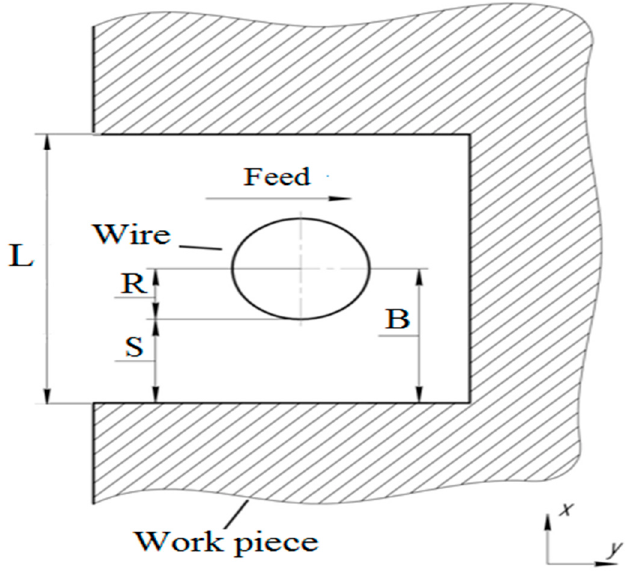
Figure 4. WIRE-EDM processing in the XY plane: R—radius of the electrode tool (ET); S—interelectrode gap;(B)—reference for correction; L—cut-width (Kerf) .